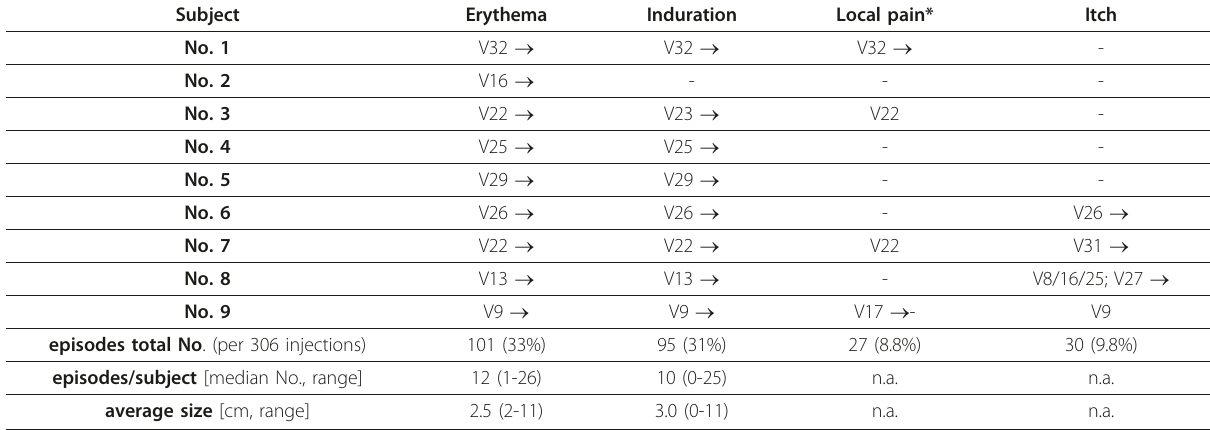
Table 2 Local reactions after autologous E.coli